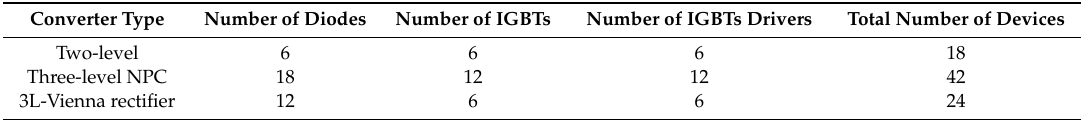
Table 1 mentions the number of devices used by all discussed circuits. Table 1. Comparison of the number of devices